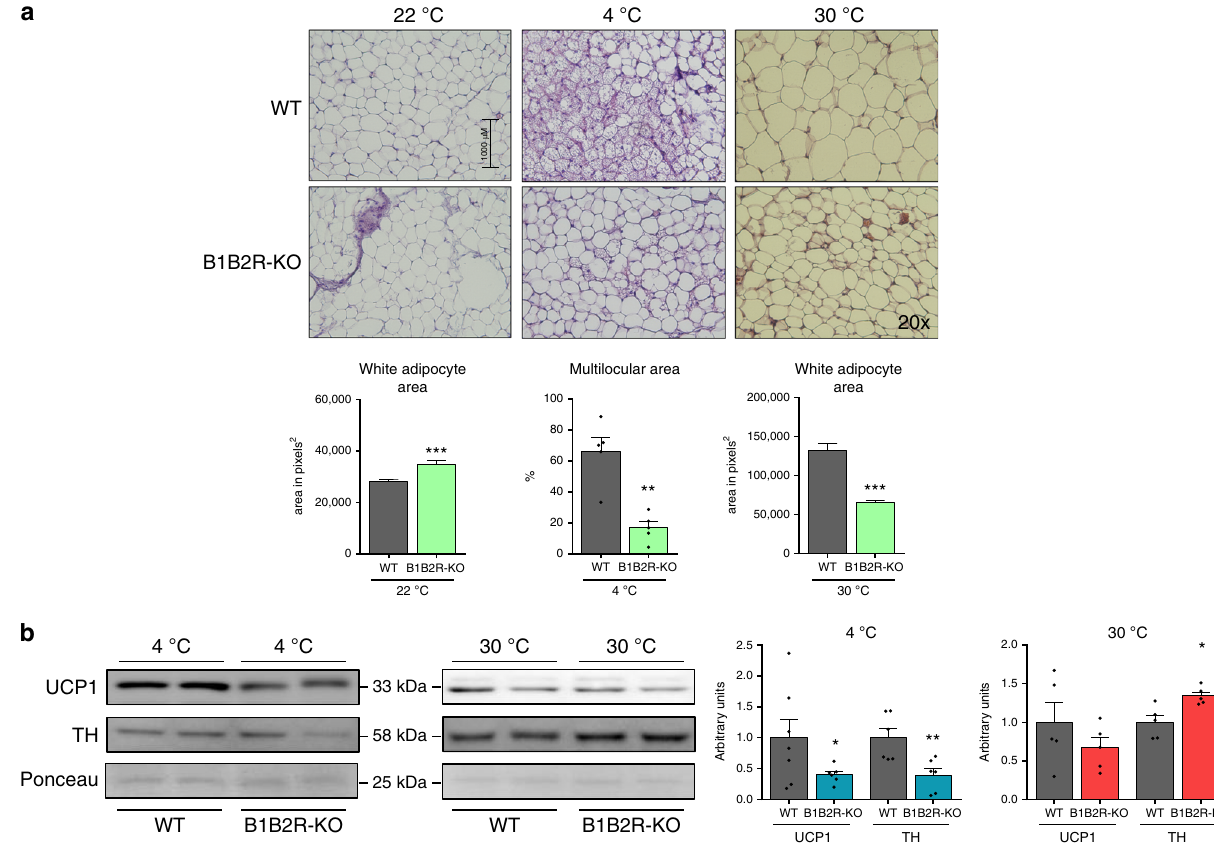
Fig. 8 Effects of temperature challenges on iWAT of B1B2R-KO mice. a H&E-stained histological sections and quanti fi cation (at least three different pictures) of cell size and browning area in iWAT from 3 months old WT and B1B2R-KO mice exposed to 4 °C or 30 °C for 1 week. b Expression and quanti fi cation of UCP1 and TH protein ( n = 6 animals at 4 °C for UCP1 and TH except WT 4 °C UCP1 where n = 7; n = 5 at 30 °C all conditions). Data are presented as means ± s.e.m. (bars). * P < 0.05, ** P < 0.01, and *** P < 0.001 versus corresponding controls; two-tailed unpaired Student ’ s t -test. Source data are provided as a Source data fi